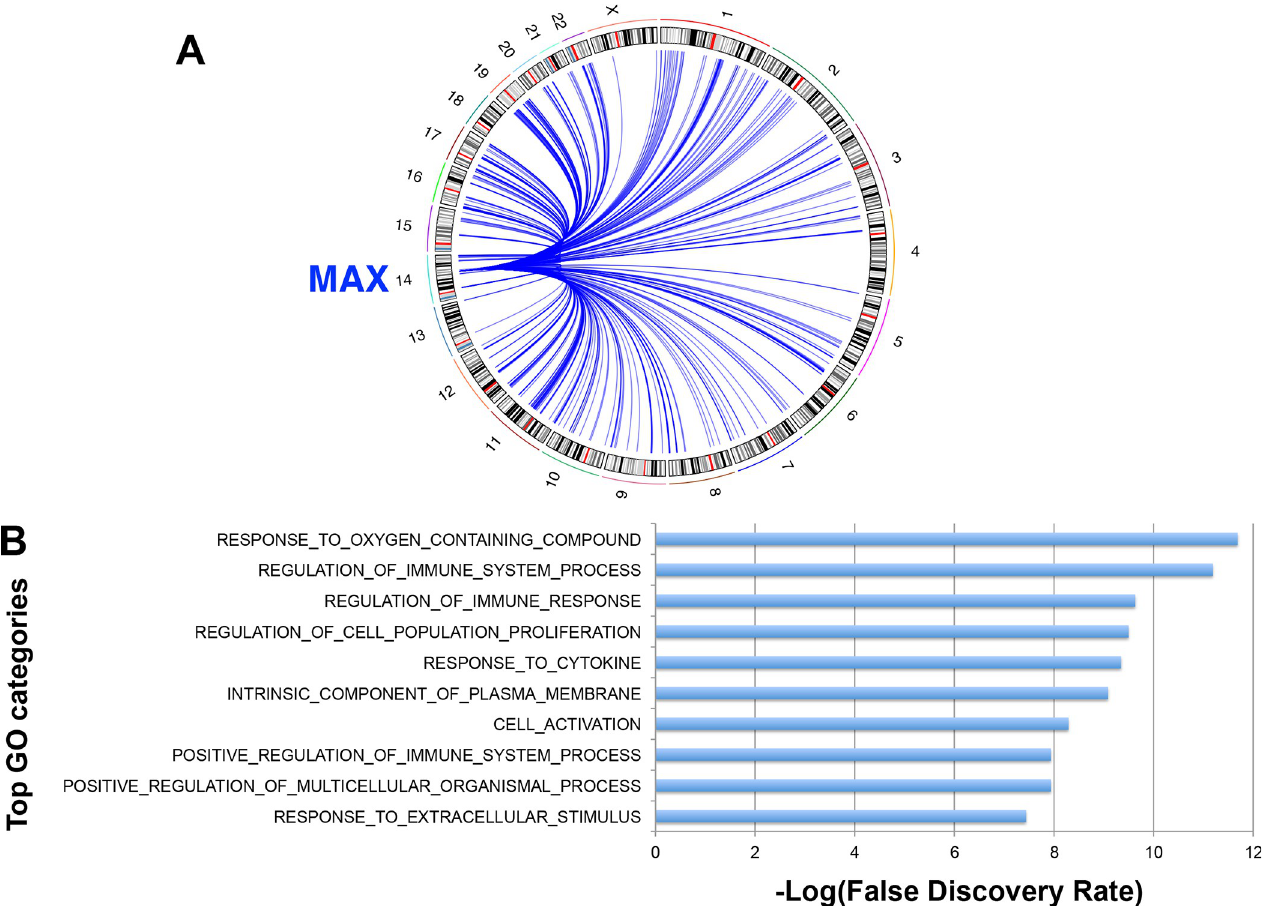
Fig 1. Genes with differentially methylated MAX binding sites at their promoters. (A) Shown is a Circos plot showing the location of genes with differentially methylated MAX binding sites. (B) Bar plot showing top gene ontology categories of differentially methylated MAX binding sites.